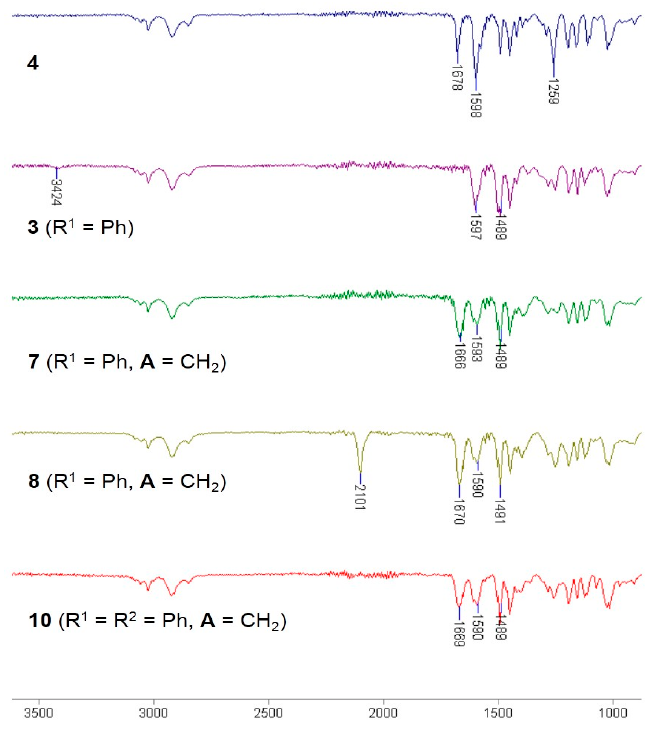
Figure 5. ATR-FTIR spectra of resins 3 , 4 , 7 , 8 and 10 (R 1 = R 2 = Ph, A = CH 2 ).